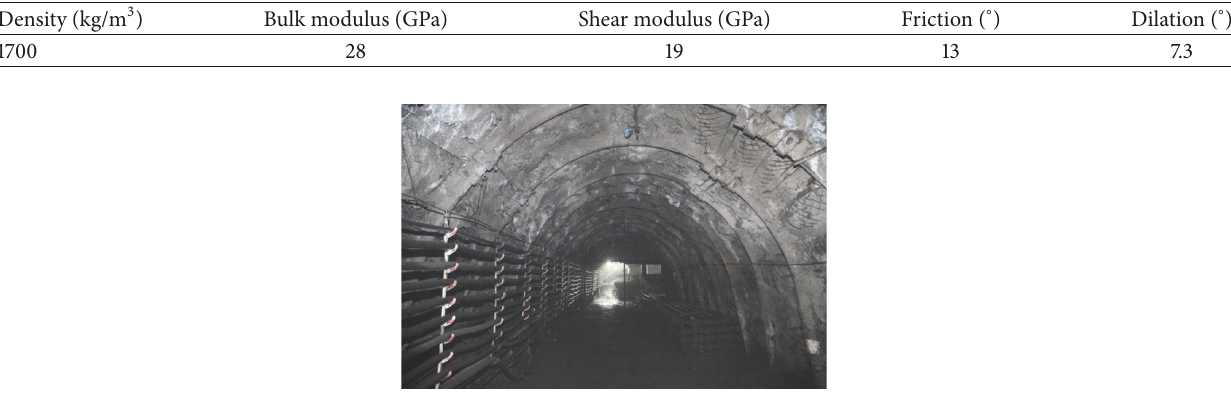
Figure 17: Tailgate profile ahead of longwall face.